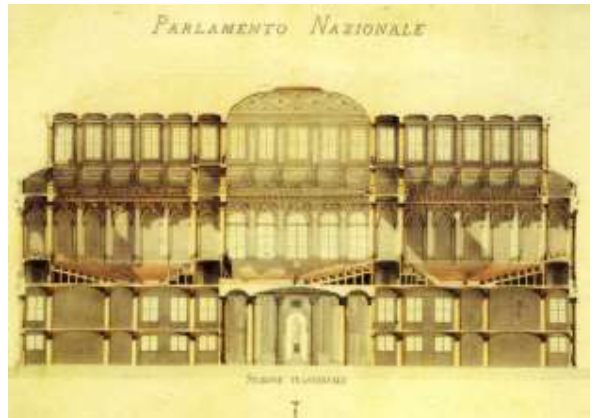
Figure 5. Alessandro Antonelli, National Parliament,